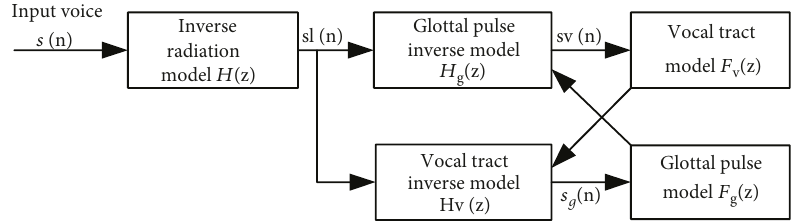
Figure 6: Estimation of the glottal pulse s